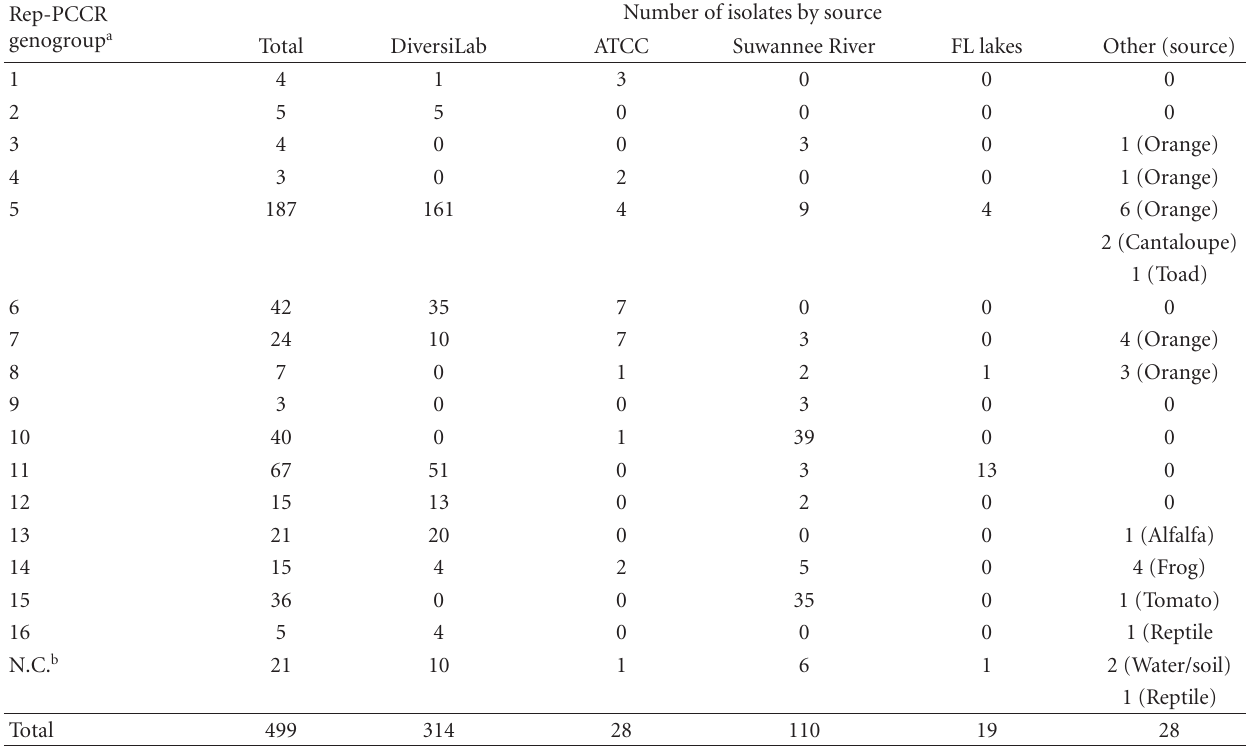
Table 2: Distribution of rep-PCR genogroups related to the source of Salmonella isolates. Rep-PCCR